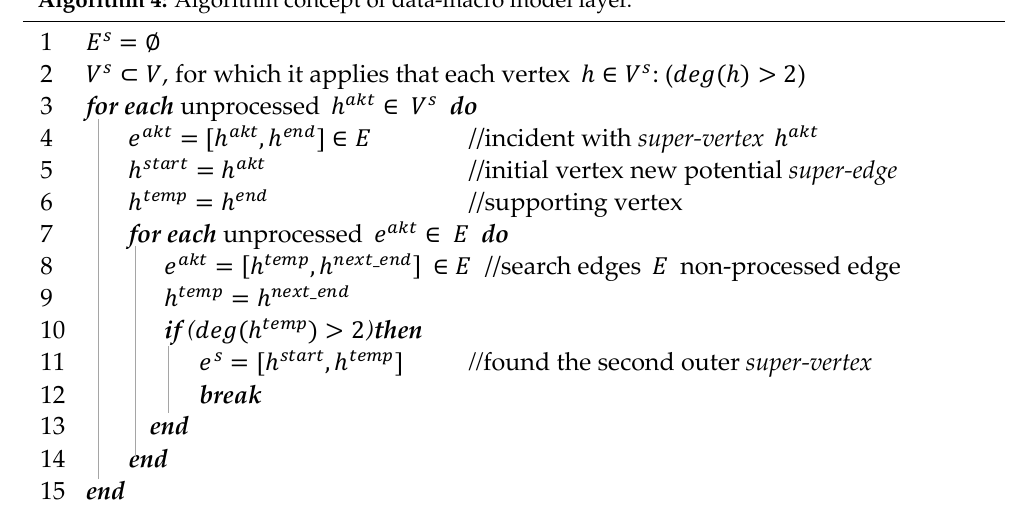
The results of the algorithm are shown in Figure